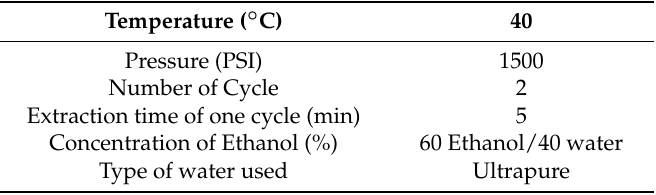
Table 4. Conditions of ASE extraction